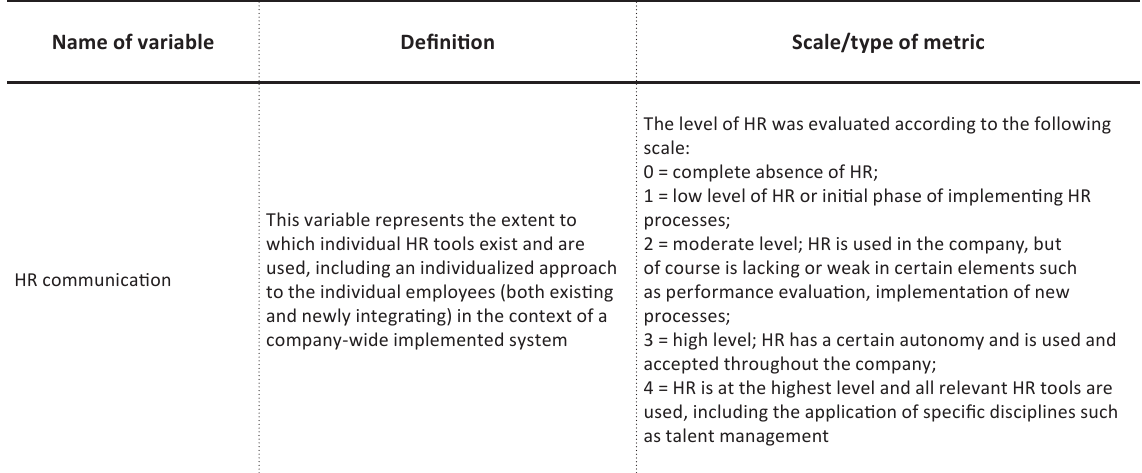
Table 1. Description of examined